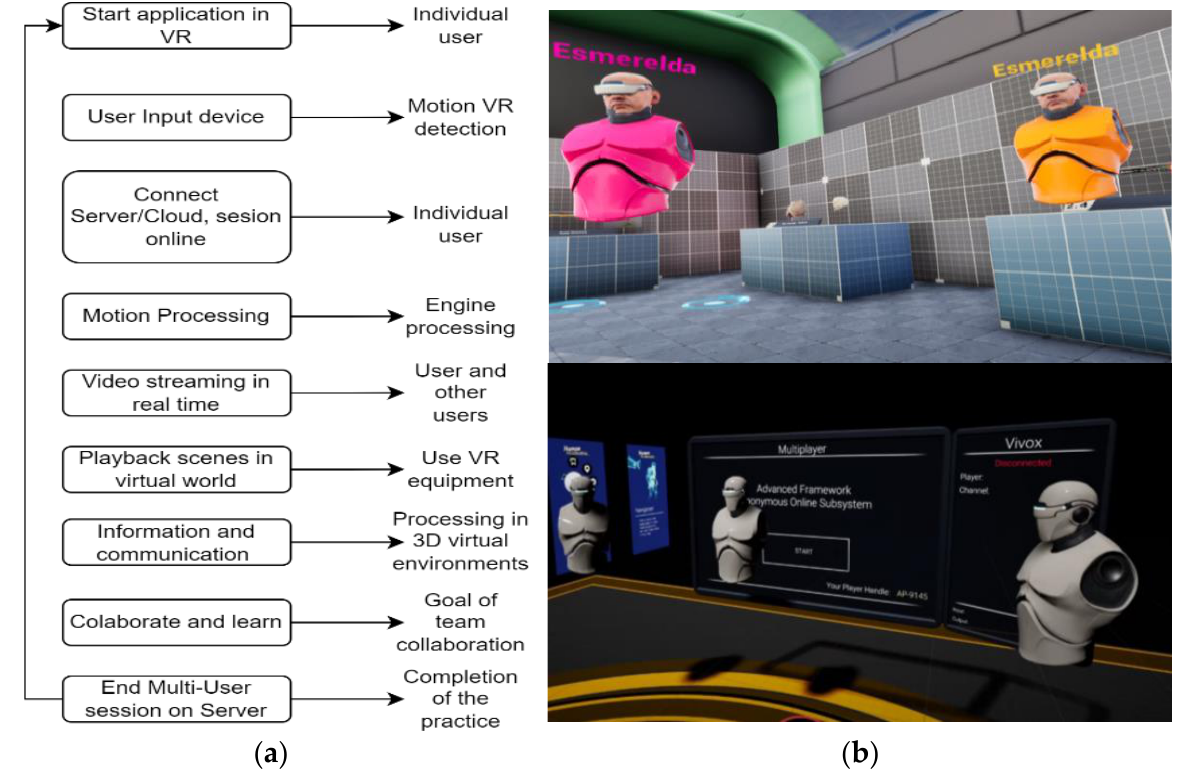
Figure 5. The avatar-based collaboration multi-user framework: ( a ) shows the process overview of VR form metaverse content; and ( b ) shows how the avatars represent users in the virtual world.